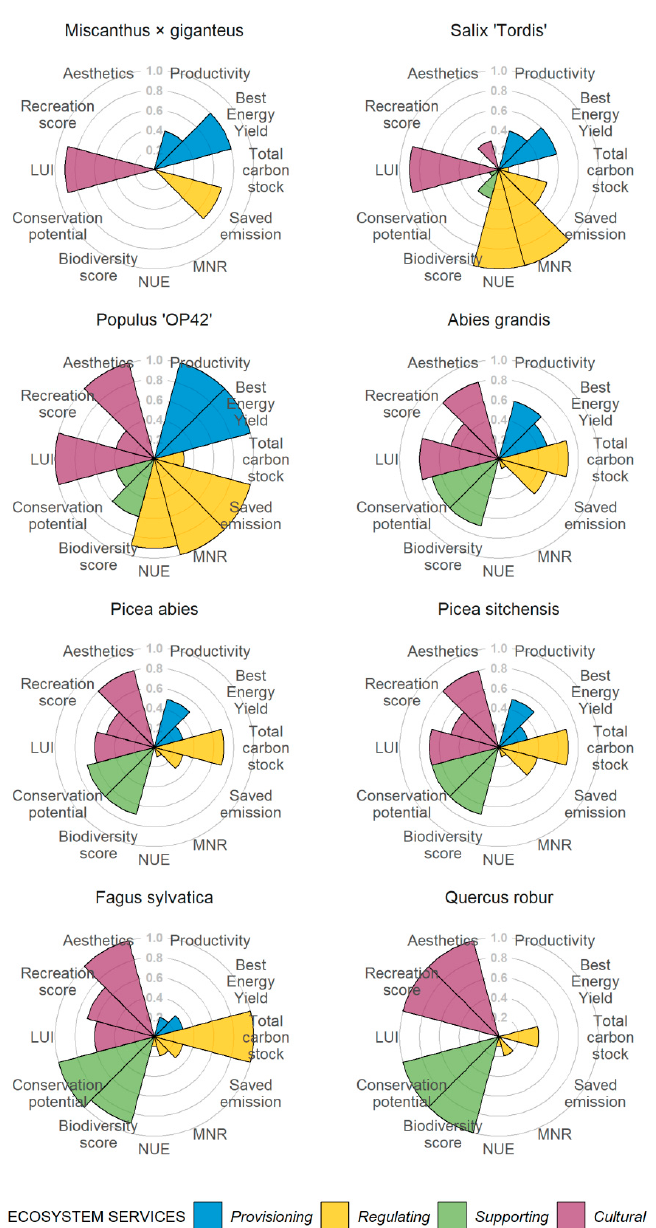
Figure 2. Species’ ecosystem service benefit profiles with all the quantified indicators. Color code: Blue = provisioning service; yellow = regulating services; green = supporting services; purple = cultural services.